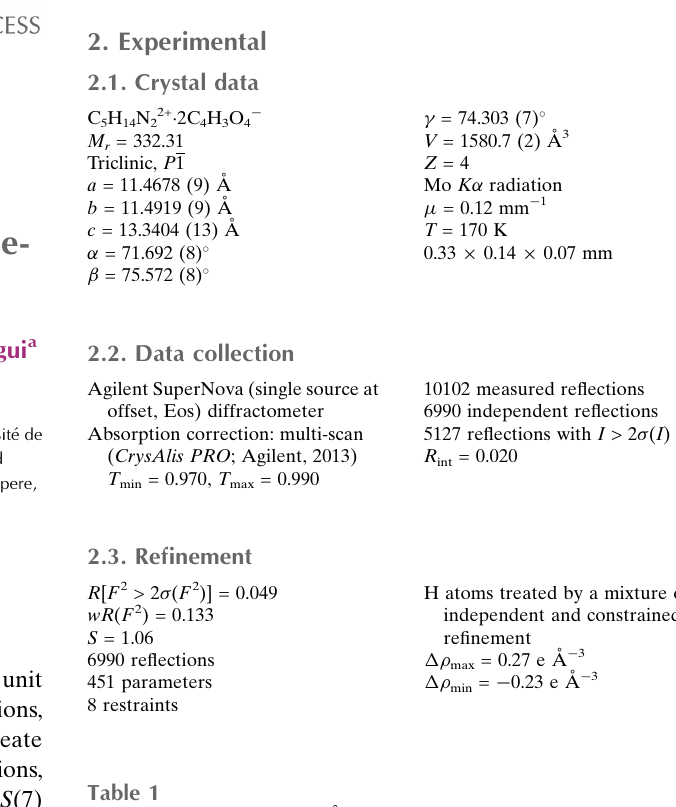
Hydrogen-bond geometry (A˚ , (cid:4)